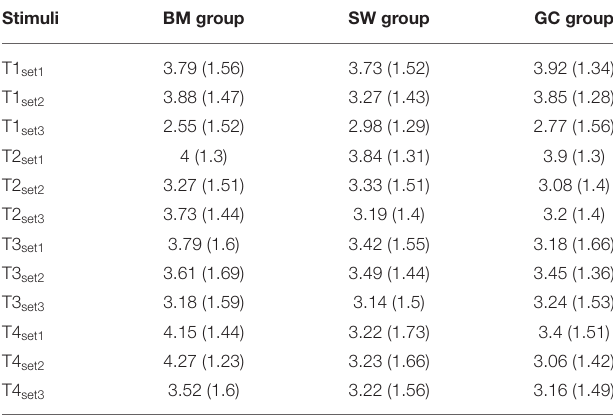
TABLE 5 | Means for tone shape description accuracy with standard deviation in parentheses. Stimuli BM group SW